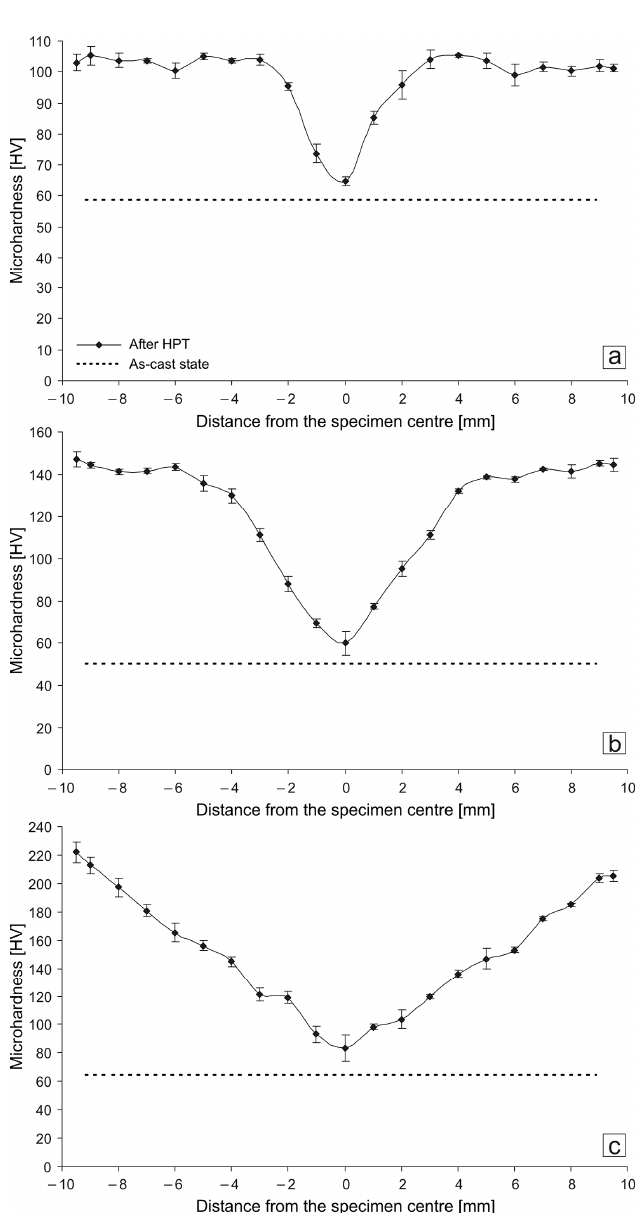
Figure 1. Microhardness distribution along the diameter of the HPT-processed specimens: ( a ) Al–10% La; ( b ) Al–9% Ce; ( c ) Al–7% Ni. La; ( b ) Al–9% Ce; ( c ) Al–7%